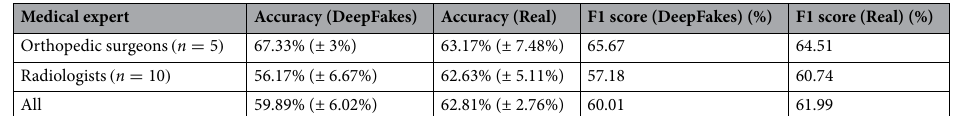
Table 2. Single-class accuracy and F1 score for all and each medical expert group, with standard deviations shown in parentheses.